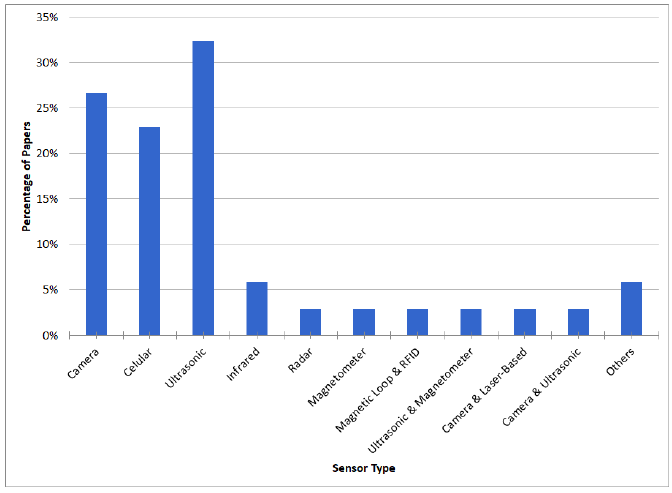
Figure 5. Sensor type.